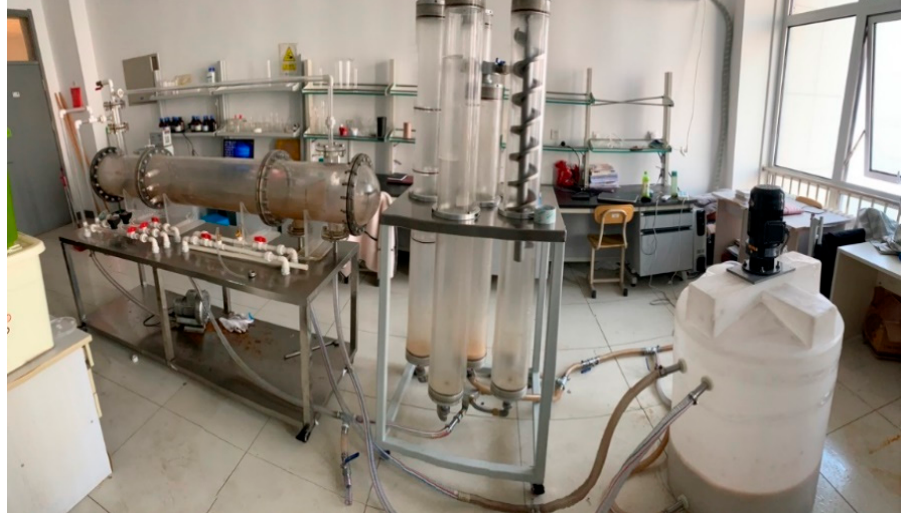
Figure 1. Proposed multistage multiphase oil–water separation system.